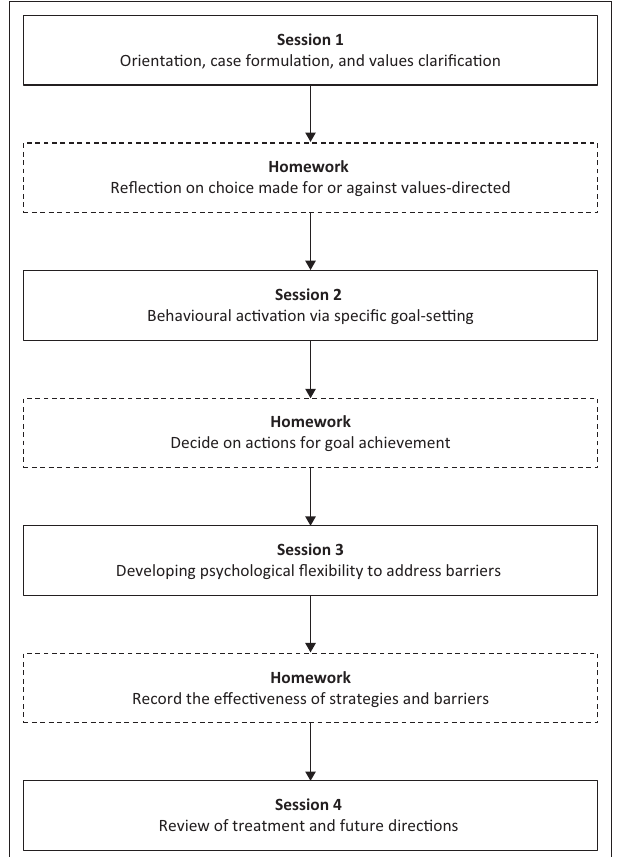
FIGURE 2: Acceptance and commitment therapy for work well-being